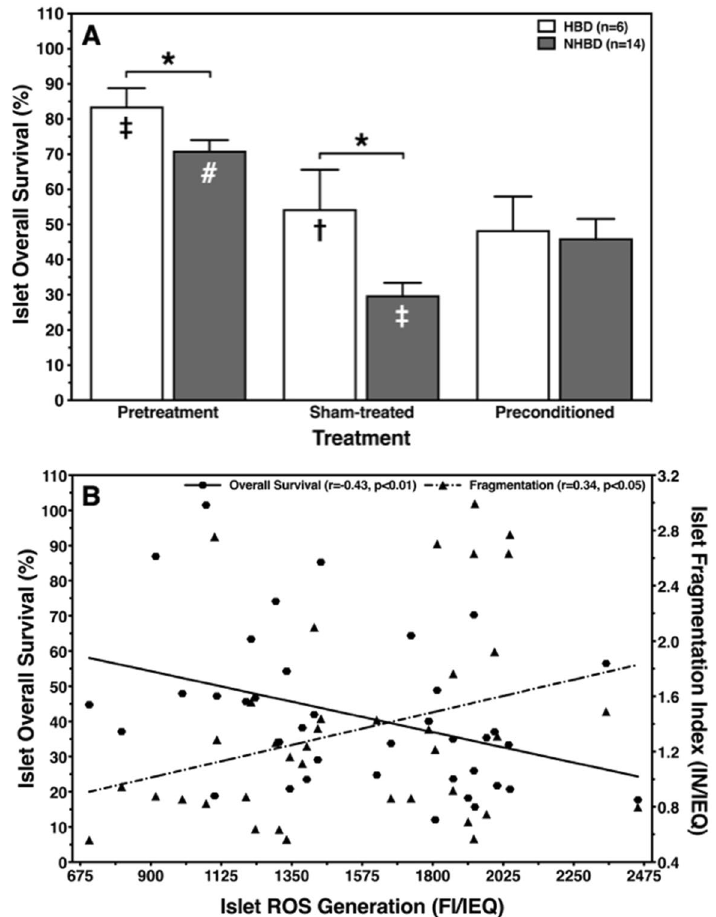
Figure 4. Ex-vivo hypoxic preconditioning increases overall survival of ischemically predamaged rat islets via ROS production. Islets were isolated from heart-beating (HBD, white bars, n = 6) and non heart-beating donors (NHBD, grey bars, n = 14). ( A ) Overall survival was assessed after preconditioning or sham-treatment followed by 24 h-culture of preconditioned or sham-treated islets in hypoxic atmosphere, respectively. ( B ) Effect of ROS production in sham-treated and preconditioned rat islets during culture in hypoxic atmosphere on postculture overall survival and fragmentation. The correlation coefficient (r) was calculated using Spearman’s rank correlation. * p < 0.05 for HBD versus NHBD. Symbols inside bars indicate † p < 0.05, ‡ p < 0.01 versus corresponding preconditioning; # p < 0.001 versus corresponding